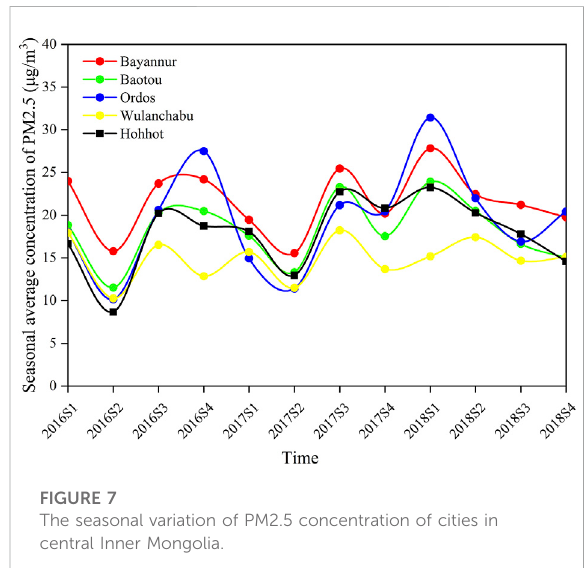
FIGURE 7 The seasonal variation of PM2.5 concentration of cities in central Inner Mongolia.